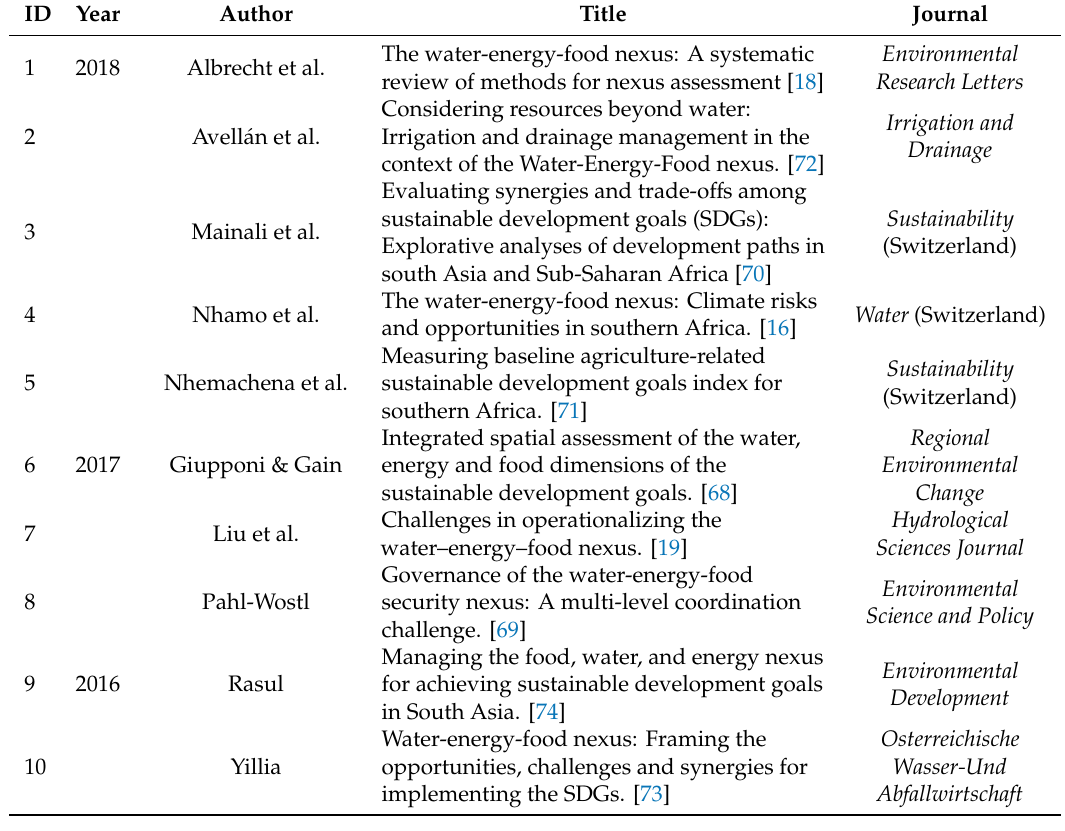
Table 5. The list of references related to SDGs and water-energy-food nexus.